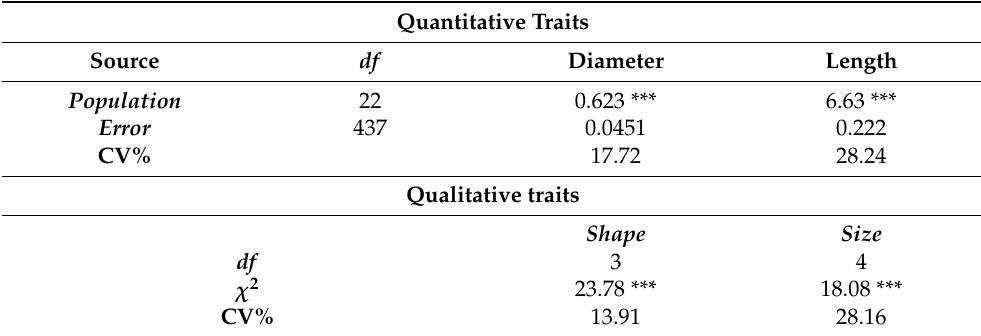
Table 3. Analysis of variance and χ 2 test of the studied morphological variables in hops plants.